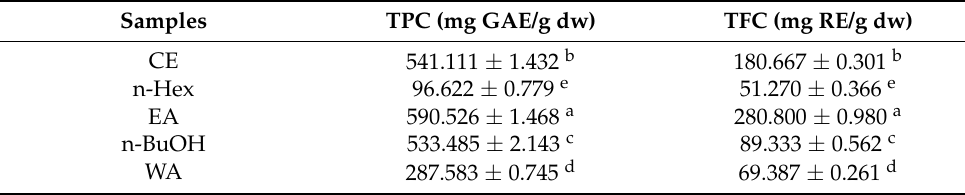
Table 1. The contents of total polyphenols and total flavones of A. indica